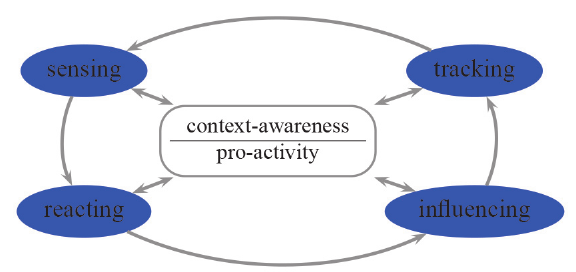
Figure 3. Context-aware and pro-activity systems, see also